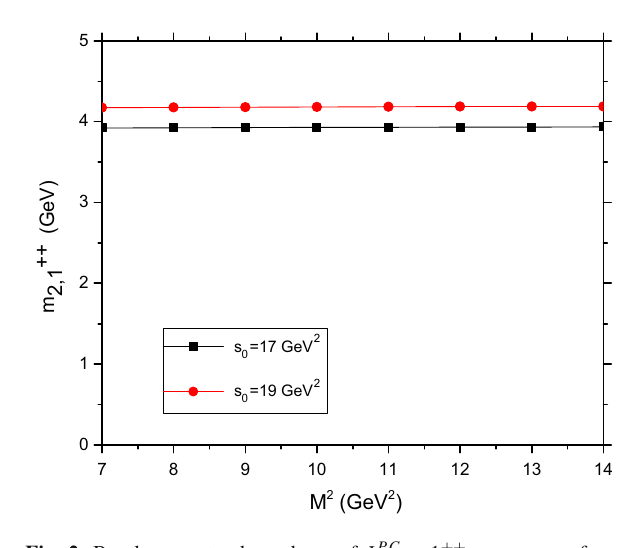
Fig. 2 Borel parameter dependence of J PC = 1 ++ meson mass from (cid:10) ( 2 ) μναβ for different s 0 values